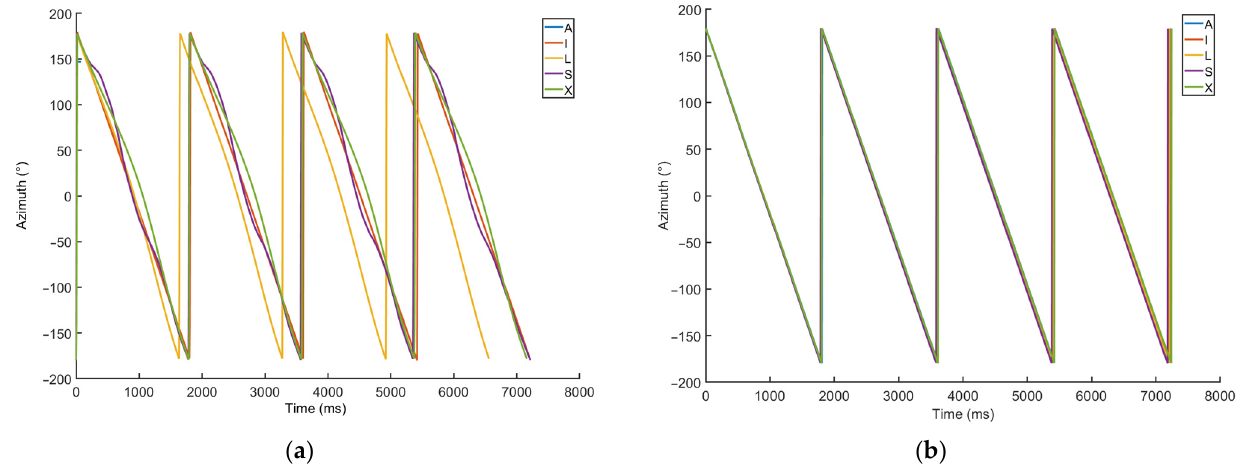
Figure 10. The comparison of the calculated azimuth for all smartphones investigated, using the platform rotating at 33 RPM: ( a ) internally precalculated by using the raw data from all sensors; ( b ) calculated by using a MATLAB function, using only the accelerometer and gyroscope data.